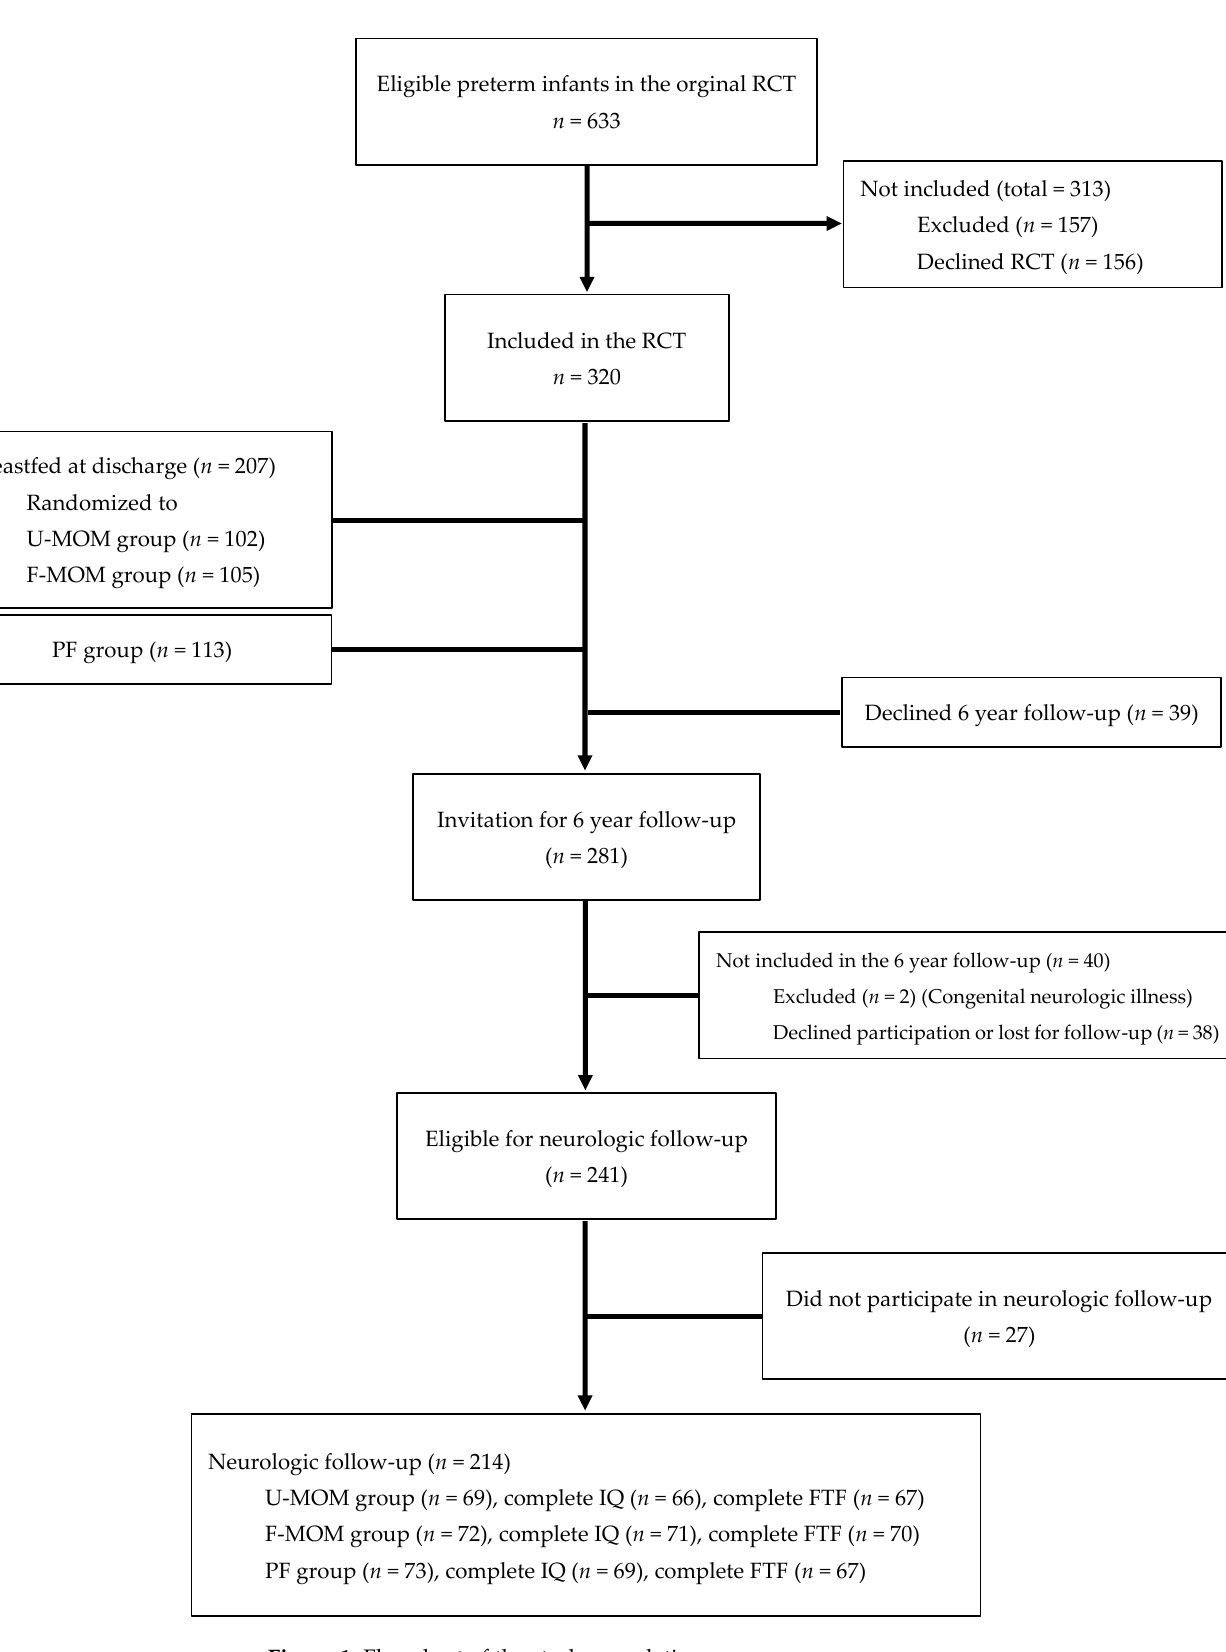
Figure 1. Flowchart of the study